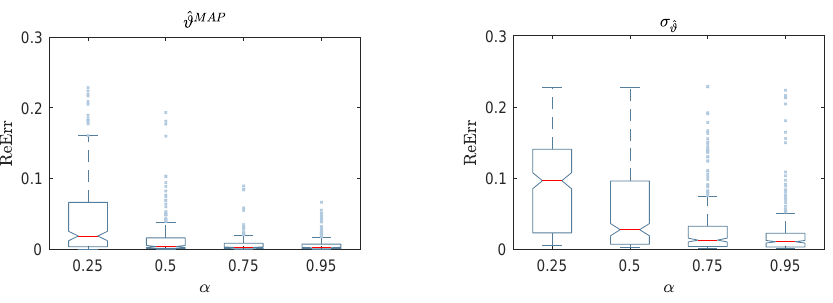
Figure 9. Box-plot of the reconstructed error (ReErr) of the identified damage location ˆ ϑ , classified based on damage severity: the MAP values ˆ ϑ MAP ( left ); and the standard deviation σ ˆ